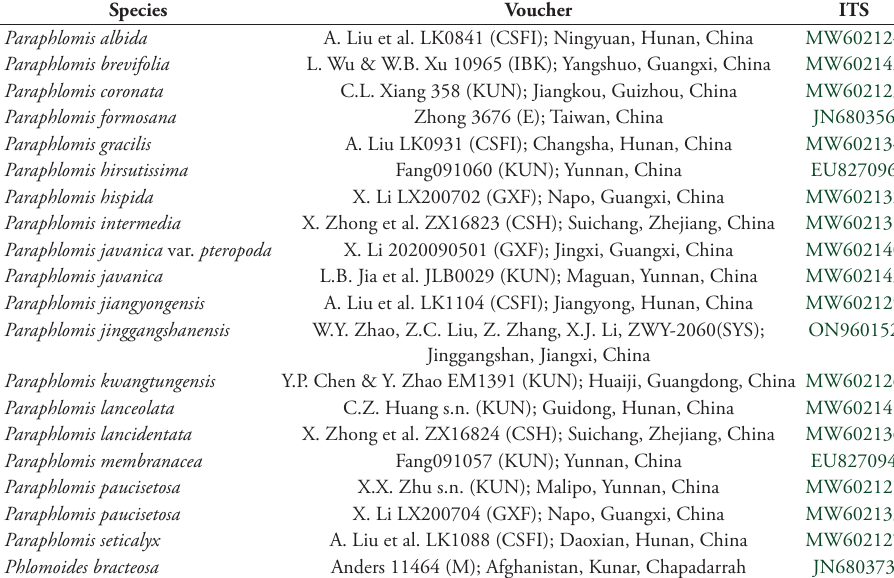
Table 1. GenBank accession numbers of the sampled species used in this